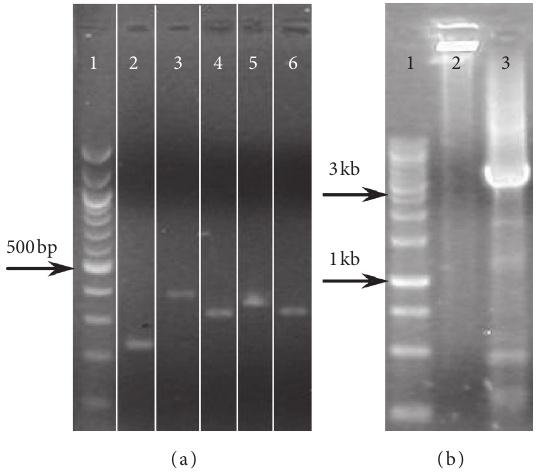
Figure 2: RT-PCR of the mfp EA operon. (a) Lane 1: MWM 100bp ladder (NEB); Lane 2: RT-PCR using primers 10-11; Lane 3: RT- PCR using primers 8-9; Lane 4: RT-PCR using primers 6-7; Lane 5: RT-PCR using the primers 4-5; and Lane 6: RT-PCR using primers 2-3. (b) Lane 1: MWM O ′ Gene Ruler 1 kb DNA ladder (Thermo Scientific); Lane 2: No Reverse Transcriptase control (NRT) using